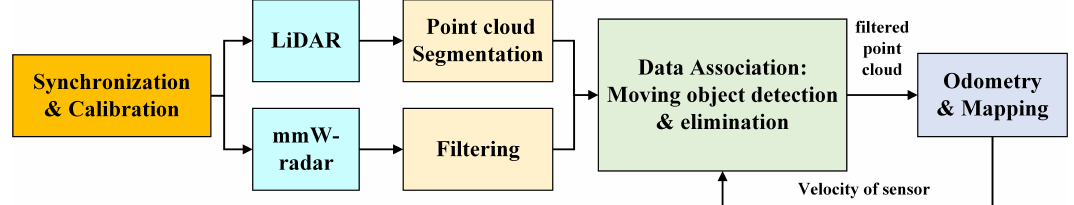
Figure 4. The system overview of moving objects